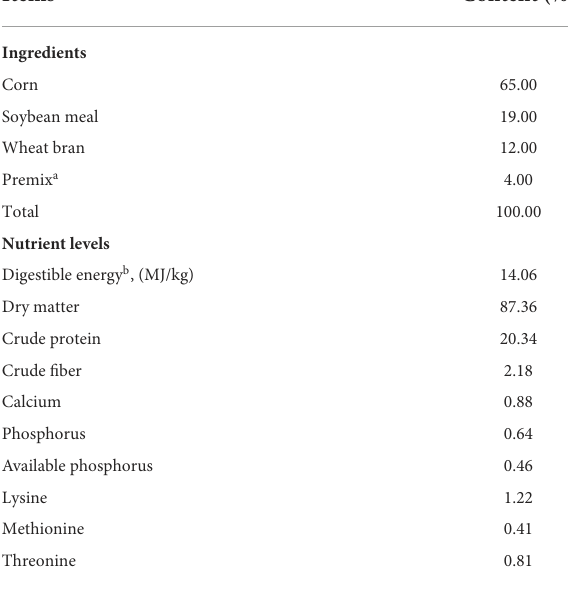
TABLE 1 Composition and nutrient levels of the basal diet (air-dry